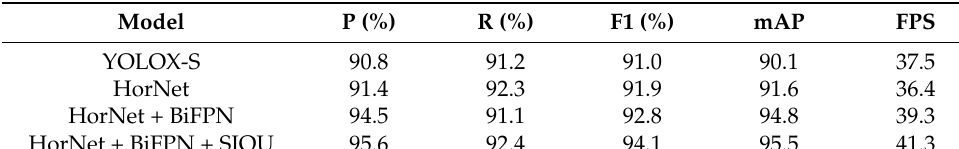
Table 2. Results of several improved ablation methods.